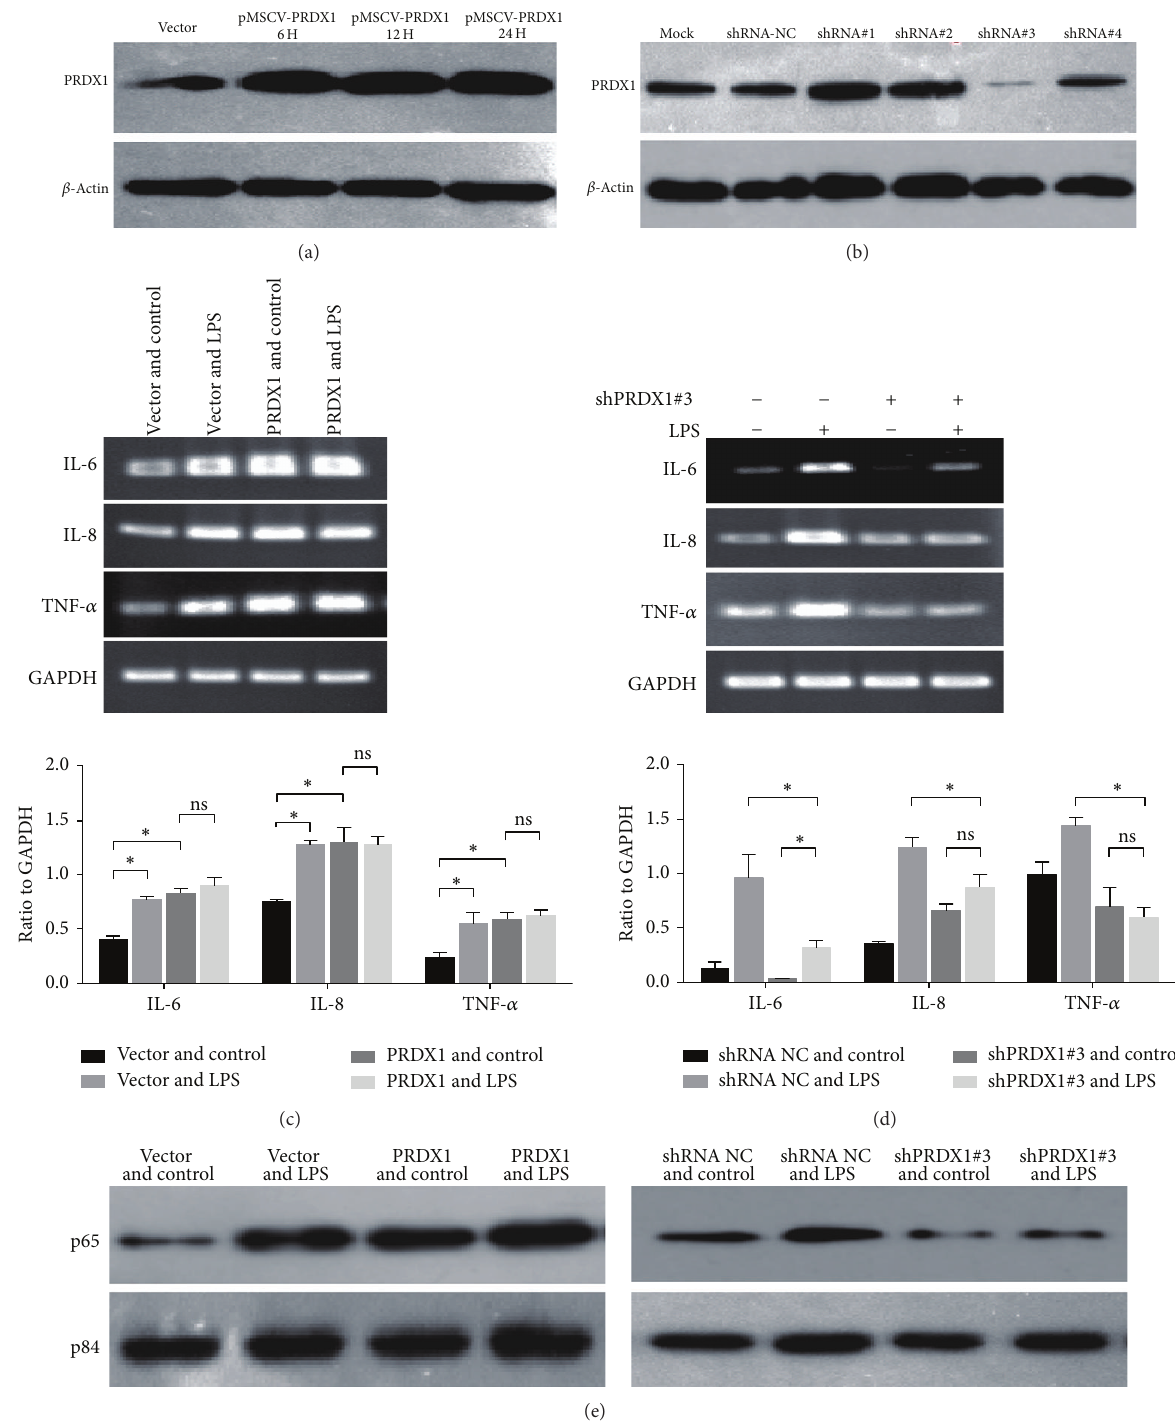
Figure5:PRDX1expressionmodulatedinflammationinairwayepitheliumcells.(a)OverexpressionofPRDX1inBEAS-2Bcellswasanalyzed by WB. 𝛽 -Actin was used as a loading control. (b) Knockdown of PRDX1 in BEAS-2B cells was analyzed by WB. 𝛽 -Actin was used as